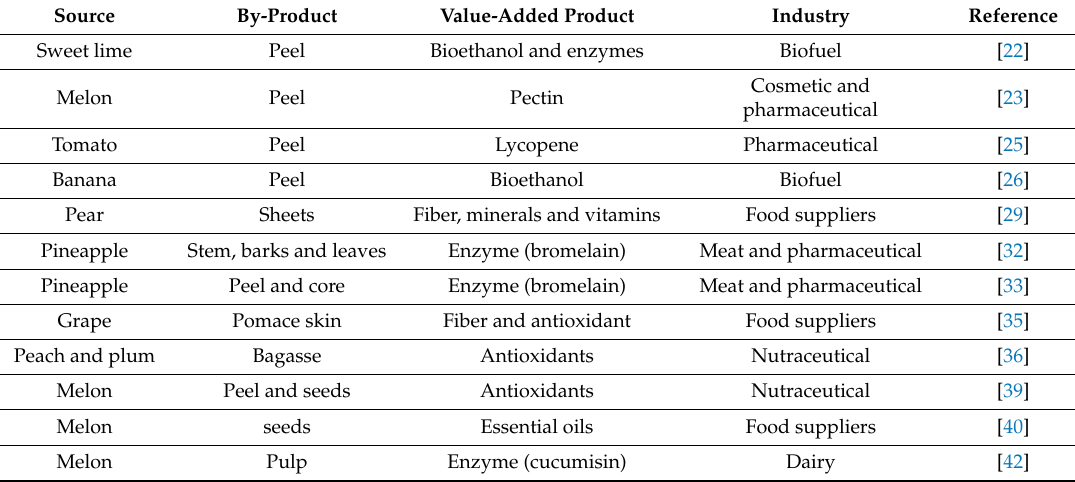
Table 1. Summary of current potential applications of fruit by-products towards industrial